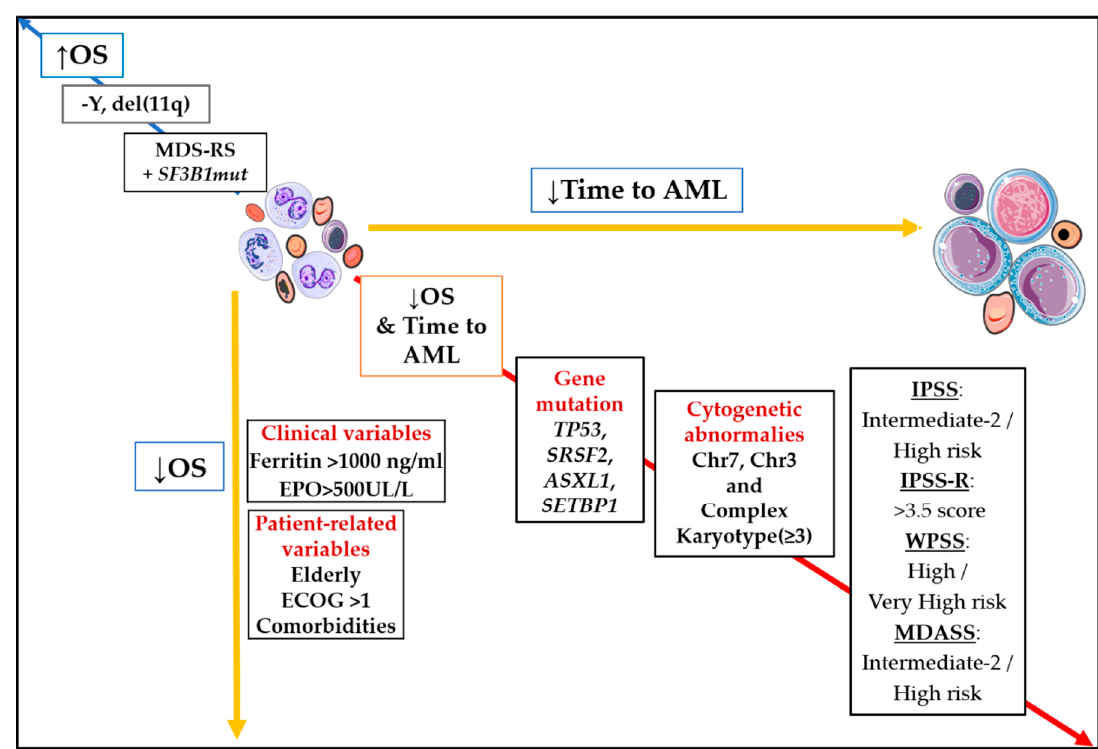
Figure 1. Impact of main prognostic markers on overall survival (OS) and time to acute myeloid leukemia (AML). Diagonal red arrow indicates factors associated both with worse OS and shorter time to AML. Opposite blue arrow is pointing out main factors are associated with better survival. Abbreviations: AML, acute myeloid leukemia; OS, overall survival; Chr, chromosome; EPO, erythropoietin; ECOG, Eastern Cooperative Oncology Group; MDS-RS, myelodysplastic syndrome with ring sideroblasts; − Y, monosomy Y; del(11q), deletion of long arm of chromosome 11; ↓ , inferior; ↑ ; superior.